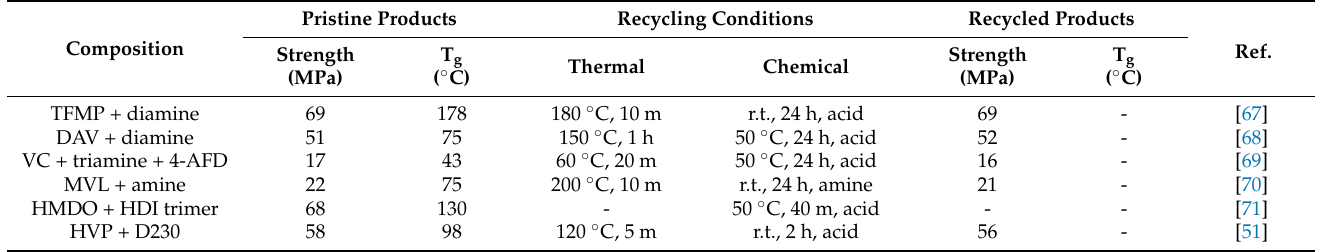
Table 2. Thermal and mechanical properties as well as recycling conditions of vanillin-modified